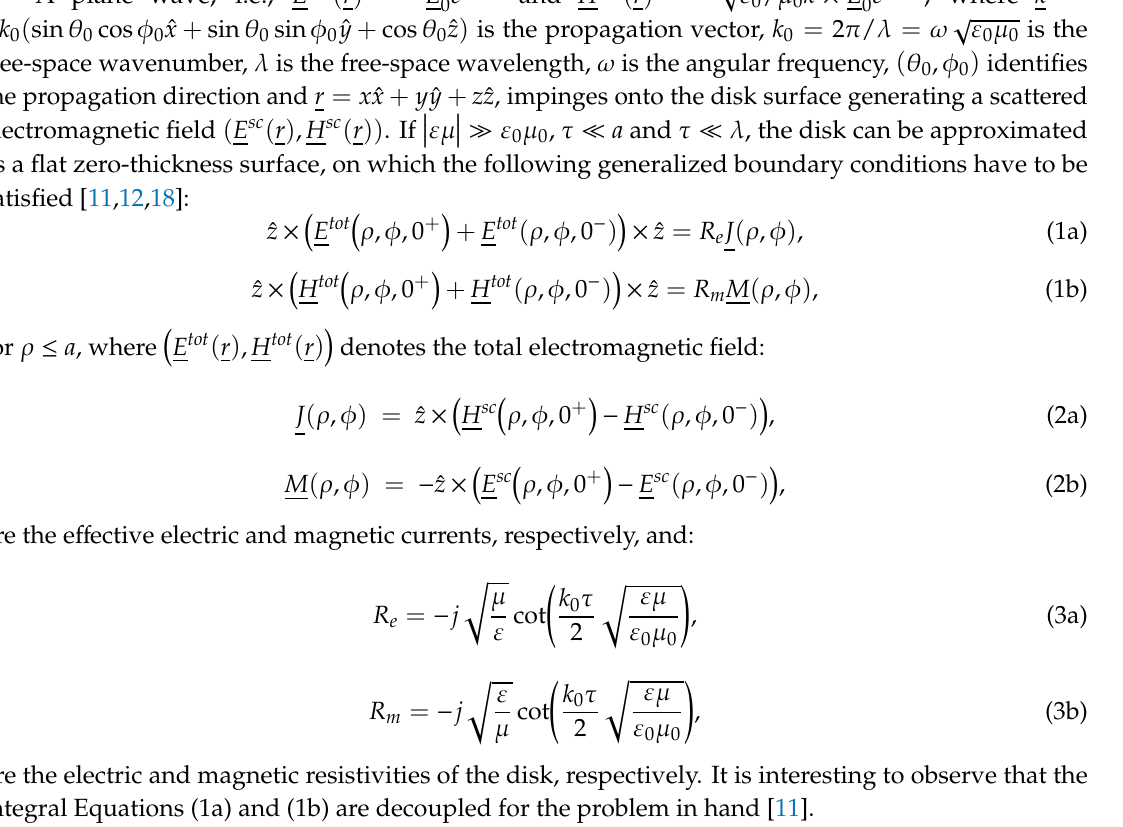
Figure 1. Geometry of the problem: ( a ) a thin dielectric disk, of radius a , thickness τ , dielectric permittivity ε and magnetic permeability μ , immersed in free space of dielectric permittivity ε 0 and magnetic permeability µ 0 ; ( b ) a plane wave impinging onto the disk surface with propagation direction